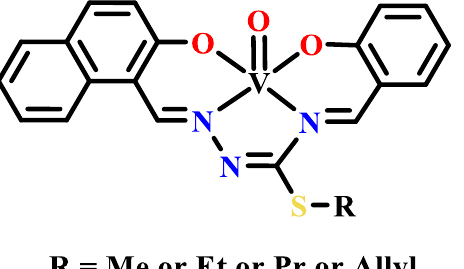
Figure 60. A series of oxovanadium(IV) complexes of naphthylhydrazone with different N -salicylic aldehyde thioureas as side chains.